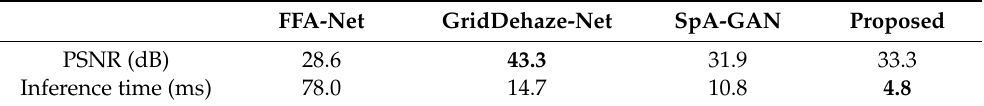
Table 5. Comparison of the denoising performance of each model on simulated noisy